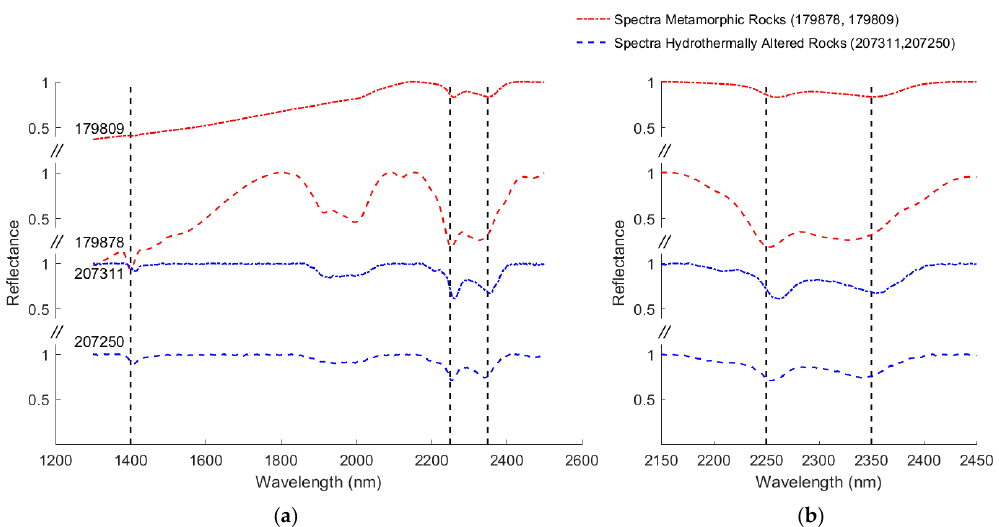
Figure 1. ( a ) Four chlorite-specific reflection spectra from both the hydrothermal and metamorphic datasets; ( b ) Zoom-in area of same spectra between 2150–2450 nm. The vertical lines highlight the characteristic absorption features of chlorite used in this study. 1400 nm: -OH absorption feature; 2250 nm: Fe-OH absorption feature; 2350 nm: Mg-OH absorption feature. To test these variations in spectral features, all reflection spectra from basaltic rocks containing chlorite have been compared. The results show that there is a significant difference, p < 0.001 for the Wilcoxon signed rank test, between the Mg-OH absorption wavelength near 2350 nm of the metamorphic rocks and the hydrothermally altered rocks. Figure 2 shows a scatter plot including a corresponding boxplot in which the spectral features are compared with the magnesium number calculated from the bulk rock composition.